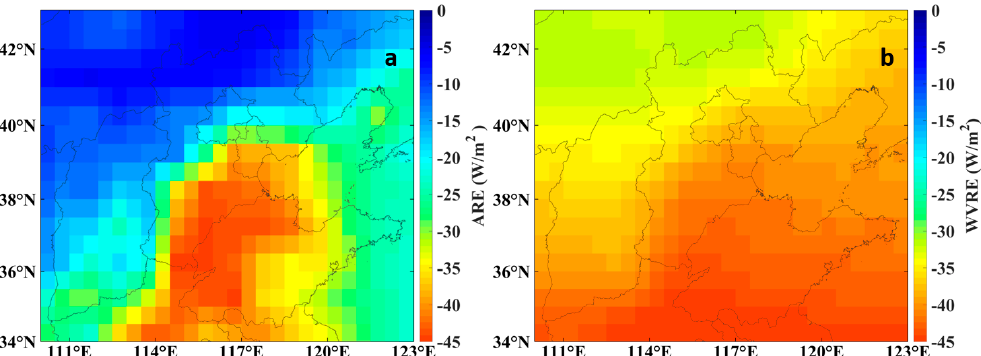
Figure 4. Spatial distribution of annual averaged ( a ) aerosol direct radiative effect (ARE) and ( b ) water vapor radiative effect (WVRE) in northern China from 2001 to 2015.